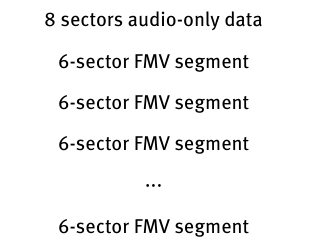
Table 1. SH FMV format.